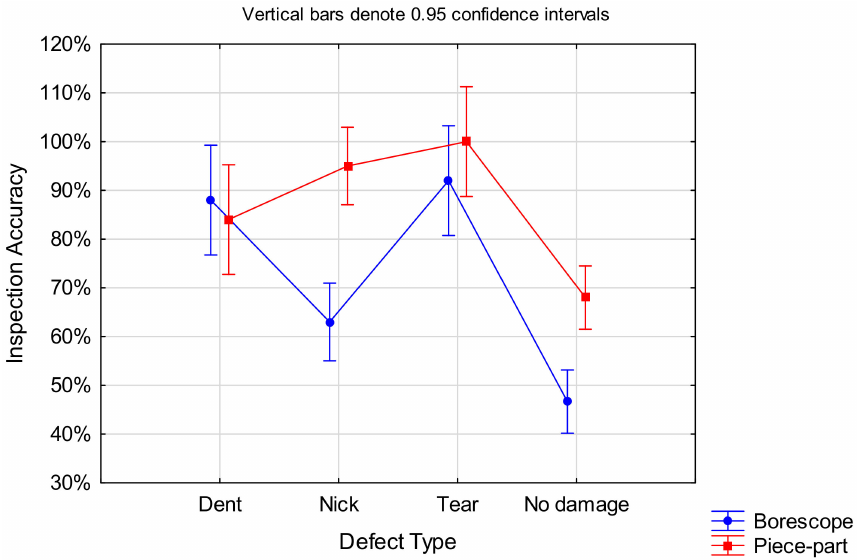
Figure 8. Effect of Inspection Type on the Inspection Accuracy for each defect group.